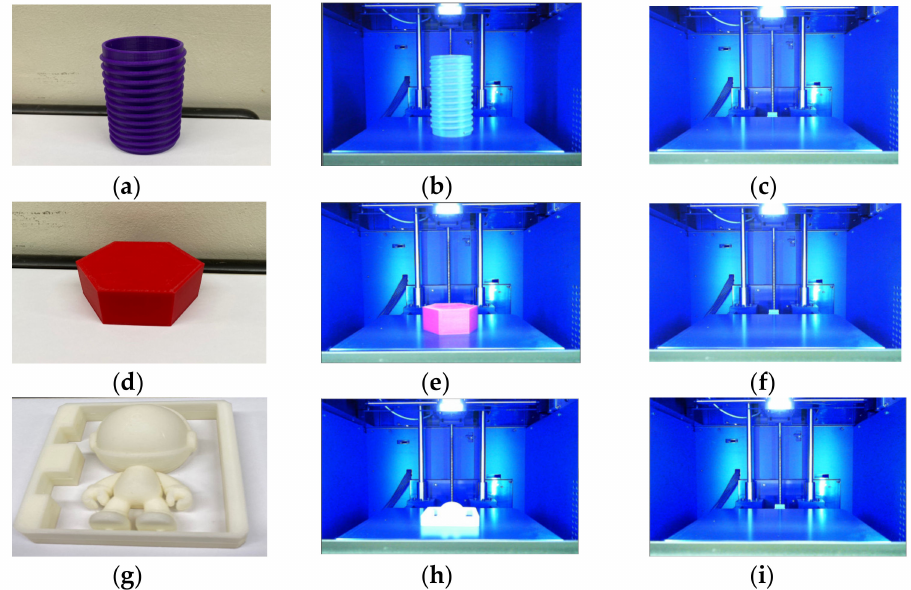
Figure 7. Test products and test environments after production is completed in 3D printers: ( a , d , g ) original Test 1,2,3 products; ( b , e , h ) foreground of original Test 1,2,3; ( c , f , i ) background of original Test